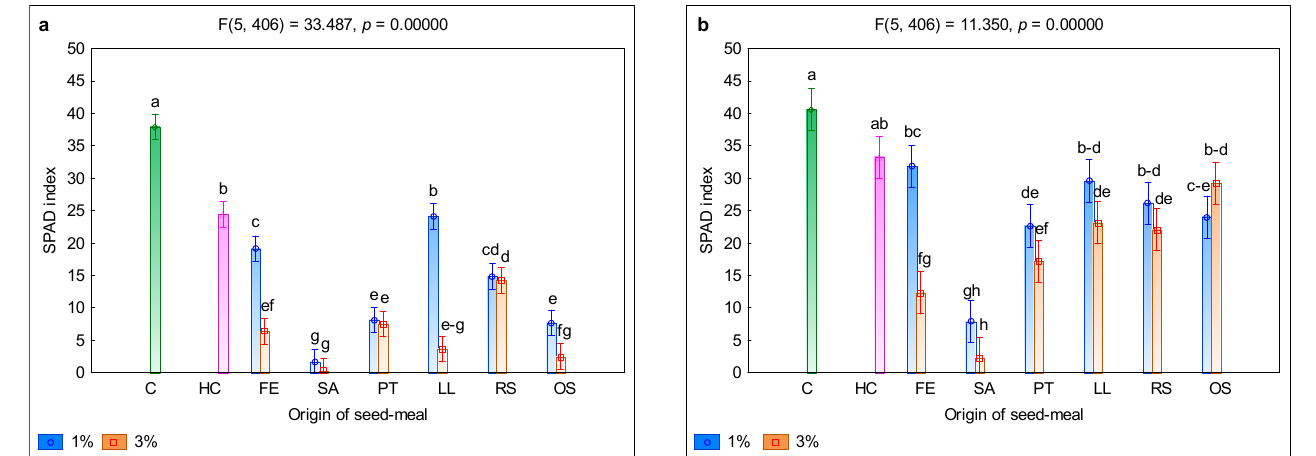
Figure 5. The mean SPAD index of herbicide-susceptible ( a ) and -resistant ( b ) biotypes of wild oat depending on the origin of seed meals and their concentration. Means with various letters are significantly different, according to Tukey test ( p ≤ 0.05). Vertical bars mean 0.95 confidence intervals. The symbols mean C—control, HC—herbicide control, and seed meals from FE— Fagophyrum esculentum , SA— Sinapis alba , PT— Phacelia tanacetifolia , LL— Lupinus luteus , RS— Raphanus sativus , OS— Ornithopus sativus . The column colors mean green—control, pink—herbicide control, blue—1% concentration of seed meals, orange—3% concentration of seed meals.